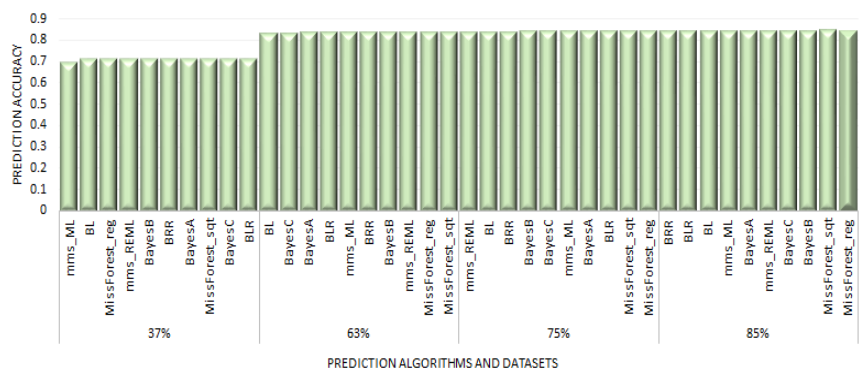
Figure 5. Prediction accuracies for FAW with RBTS across algorithms and training sets with different sizes in percent of the total panel.